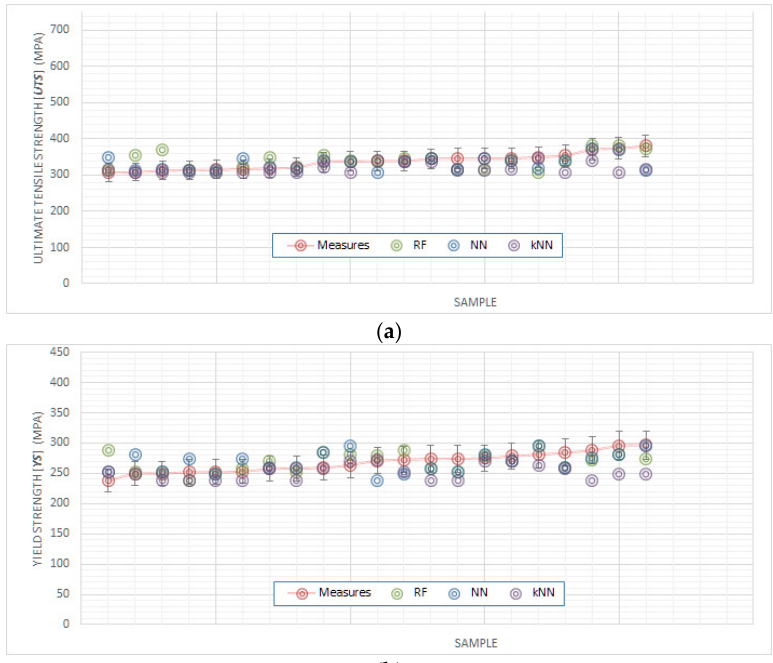
Figure 1. Metallurgical properties (( a ) Ultimate Tensile Strength (UTS), ( b ) Yield Strength (YS), ( c ) Ultimate Strain ( ε ), ( d ) Young’s modulus ( E )) in the case of Spheroidal Graphite Iron (SGI), as measured and